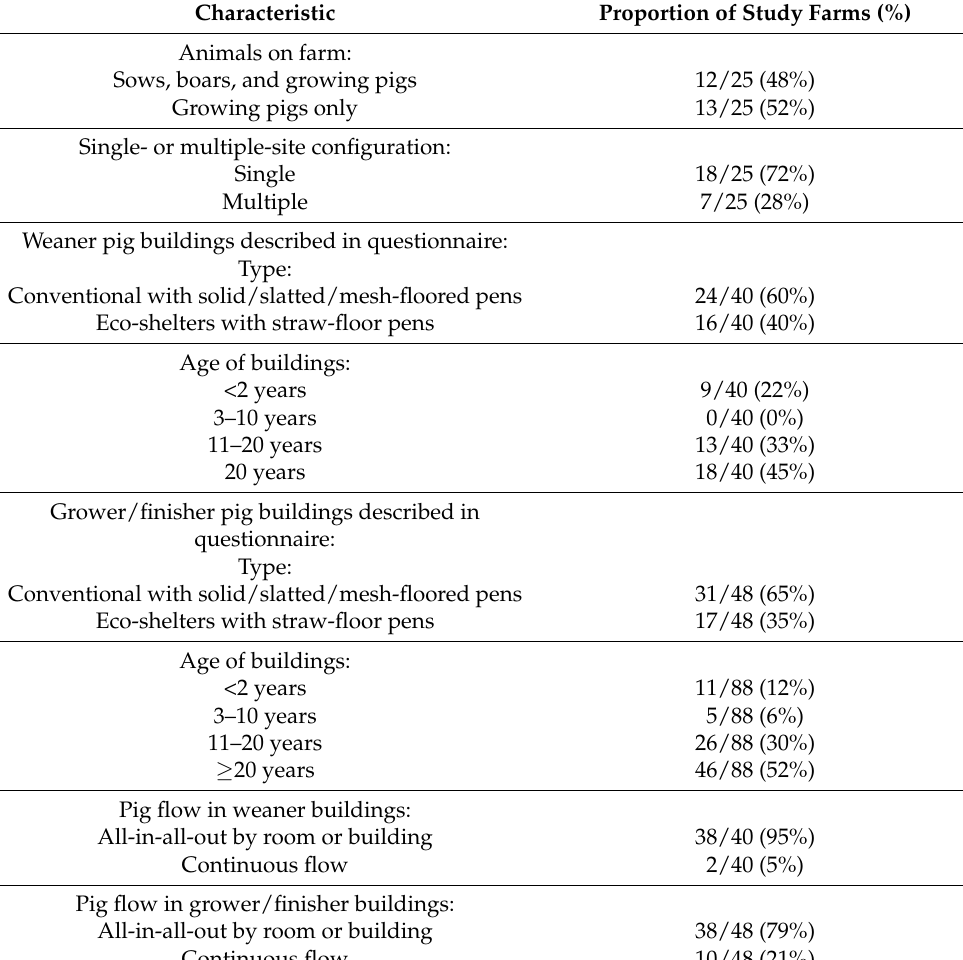
Pig flow in weaner buildings: All-in-all-out by room or